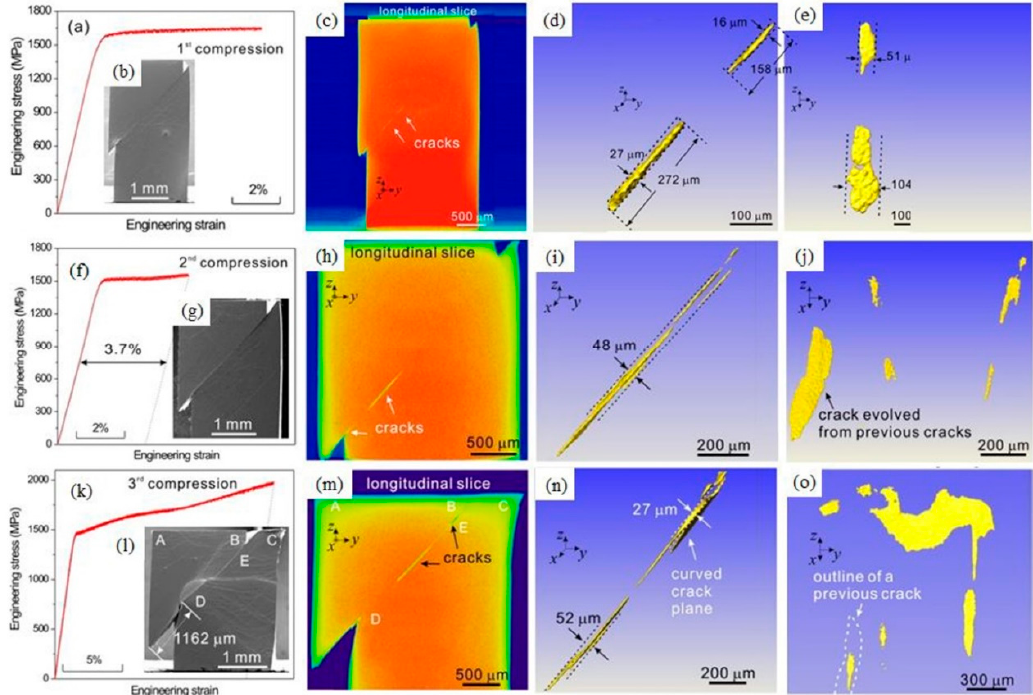
Figure 3. Shear band cracking behavior in an in situ compression test. The compression, SEM, and XRT results in the rows after the first stop ( a – e ), after the second stop ( f – j ), and after the third stop ( k – o ), respectively [107].